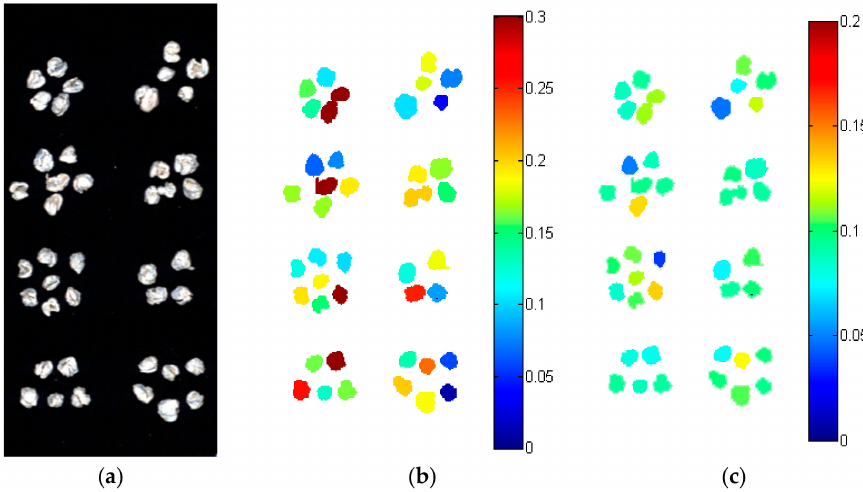
Figure 3. ( a ) Pseudo image of Fritillaria thunbergii bulbi (generated from gray-scale images at 1000, 1200, and 1400 nm) in addition to prediction maps of ( b ) peimine and ( c ) peiminine content in Fritillaria thunbergii bulbi. The peimine and peiminine content are